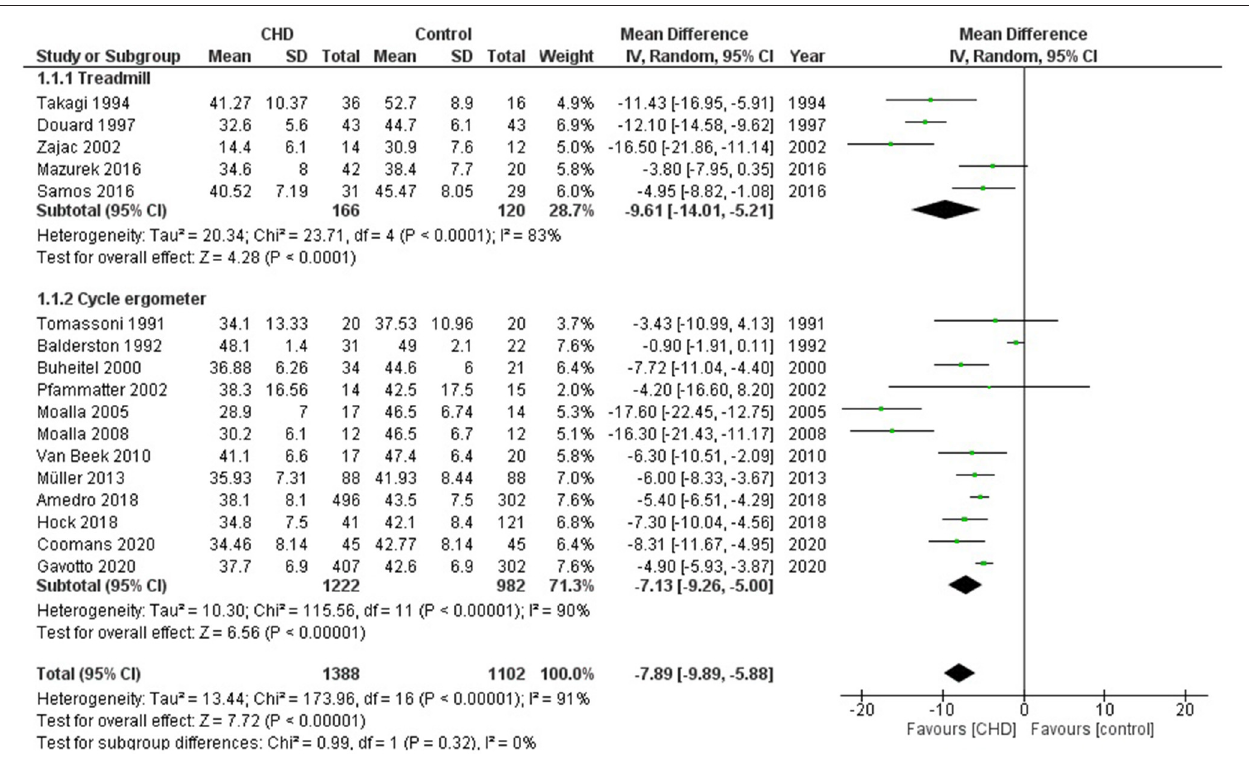
FIGURE 2 | Forest plot for mean peak oxygen consumption for CHD in children and adolescents and healthy controls.